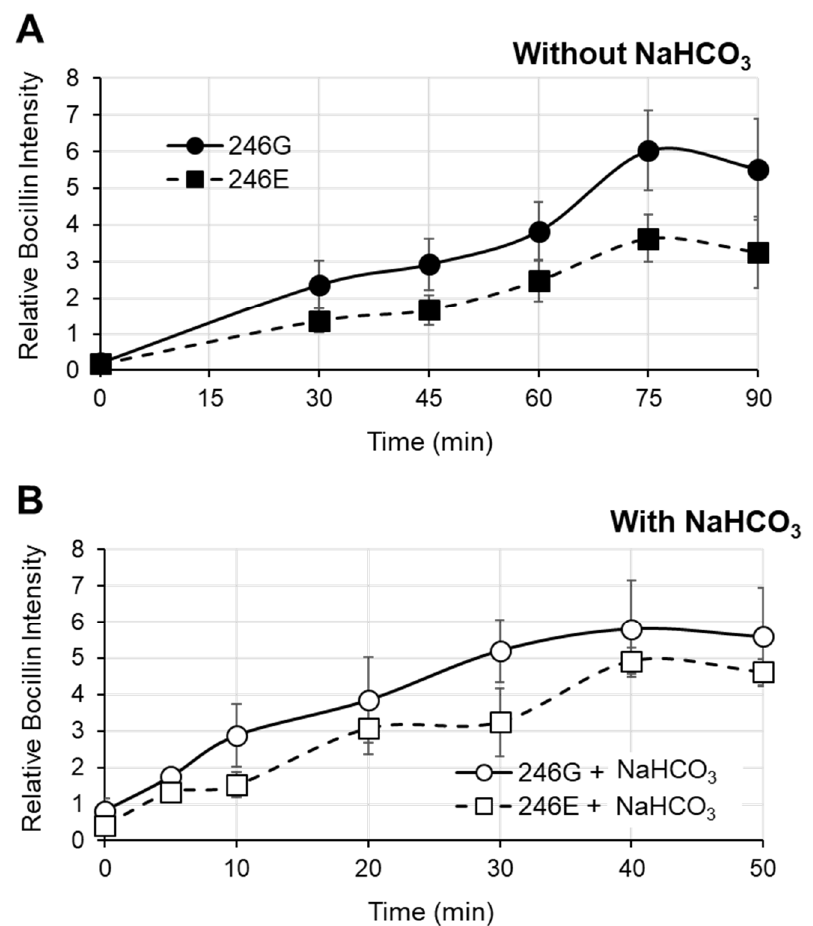
Figure 3. Kinetic binding of Bocillin-FL to purified PBP2a variants 246G and 246E. ( A ) Kinetic Bocillin-FL binding without NaHCO 3 . ( B ) Kinetic Bocillin-FL binding with NaHCO 3 . A total of 50 µg/mL PBP2a was used in each Bocillin binding reaction. Relative Bocillin intensity was determined by normalizing absolute intensity values for each sample to the intensity of 25 µM Bocillin bound to 50 µg/mL 246G PBP2a in the absence of NaHCO 3 incubated for 20 min run on the same gel.